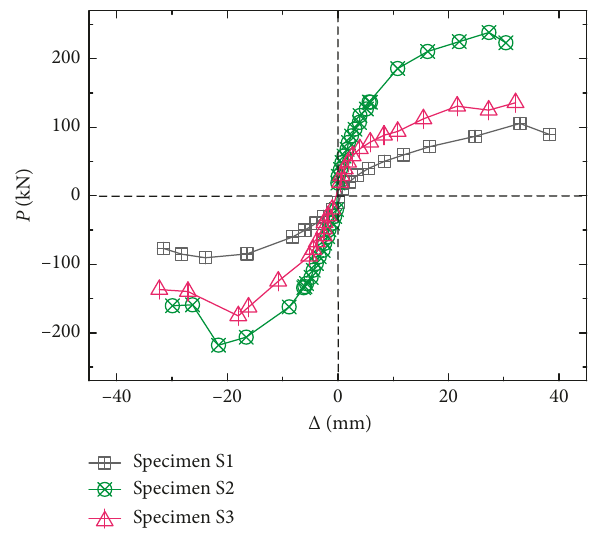
Figure 7: Skeleton